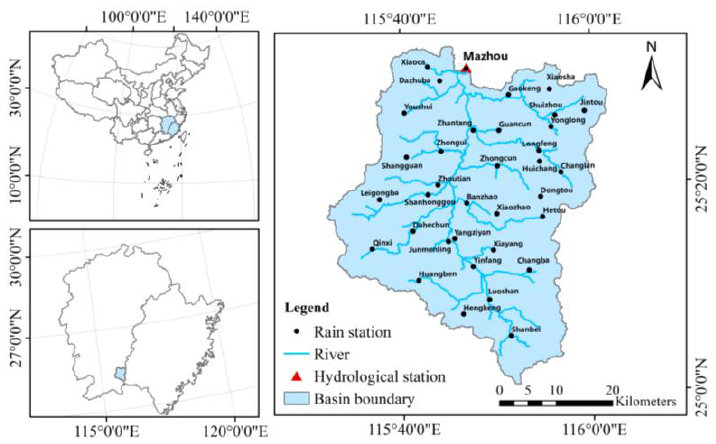
Figure 5. Location of the Mazhou Basin (China) and distribution of stations in the basin.